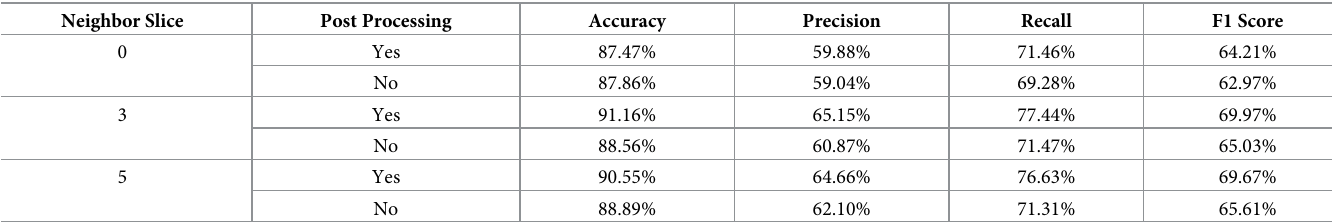
Table 1. Performance of the model vs. the size of the block and post processing. Neighbor